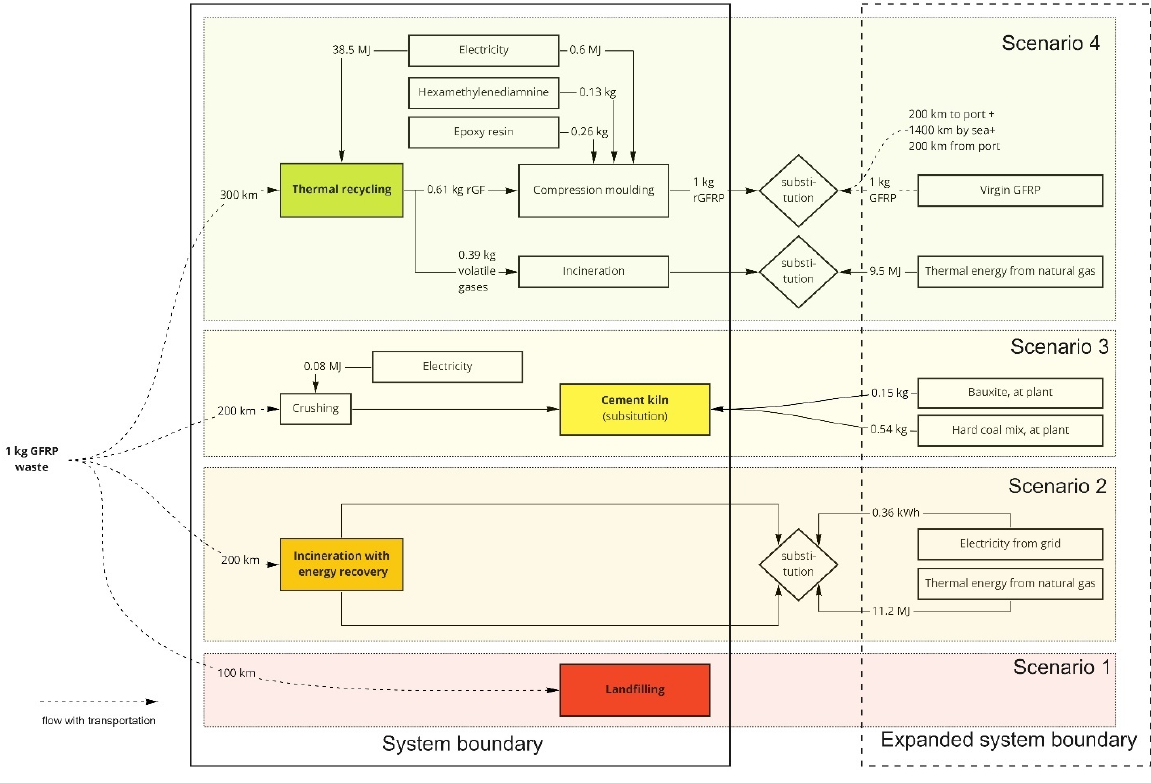
Figure 3. System boundaries of the studied and expanded systems for GFRP waste management.